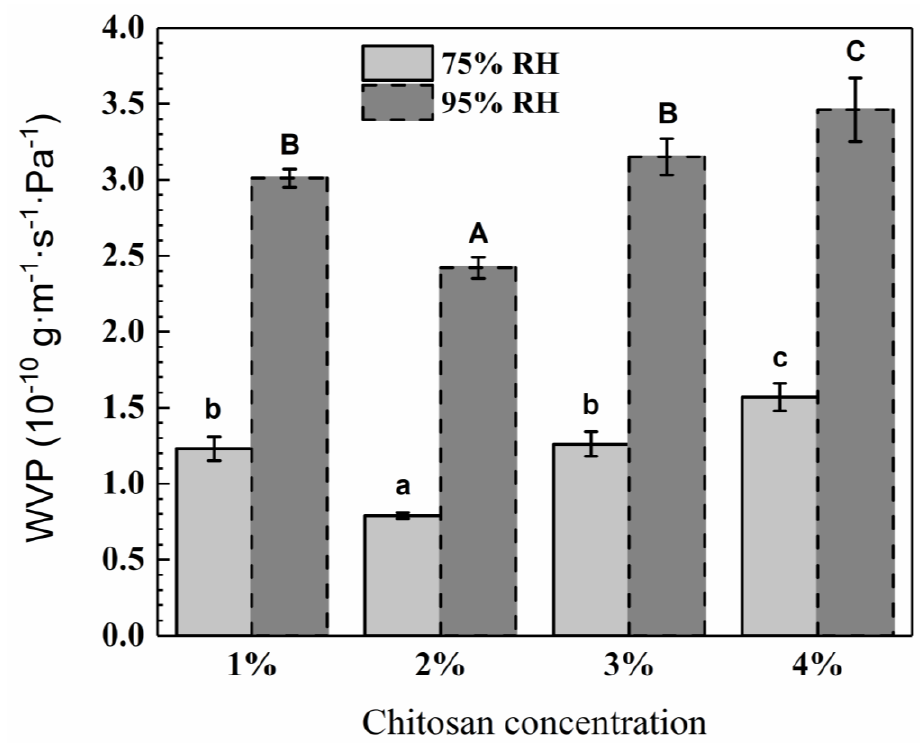
Figure 4. WVP of chitosan films. Small letters in 75% RH group, p < 0.05; capital letters in 95% RH group, p < 0.05.